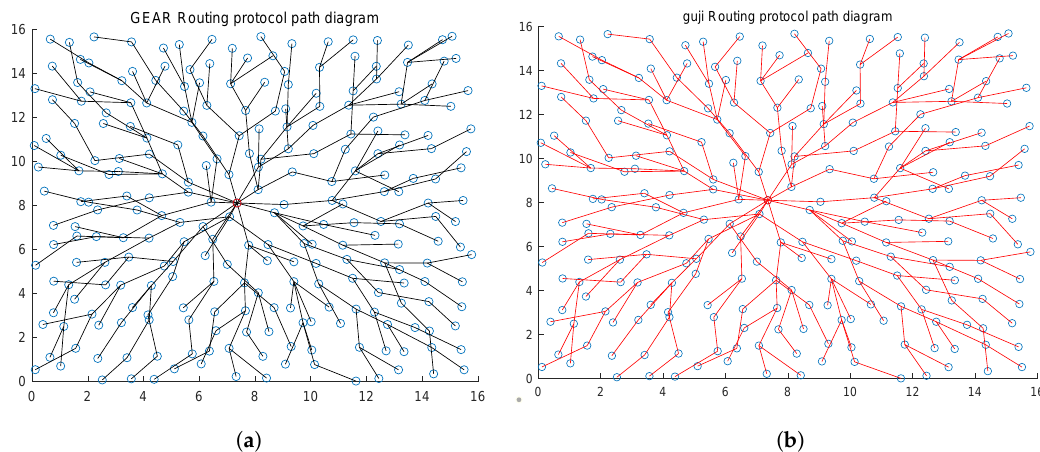
Figure 12. Part ( a ) is the original topology of the target network of GEAR routing protocol, and Part ( b ) is the topology rebuilt by the platform.